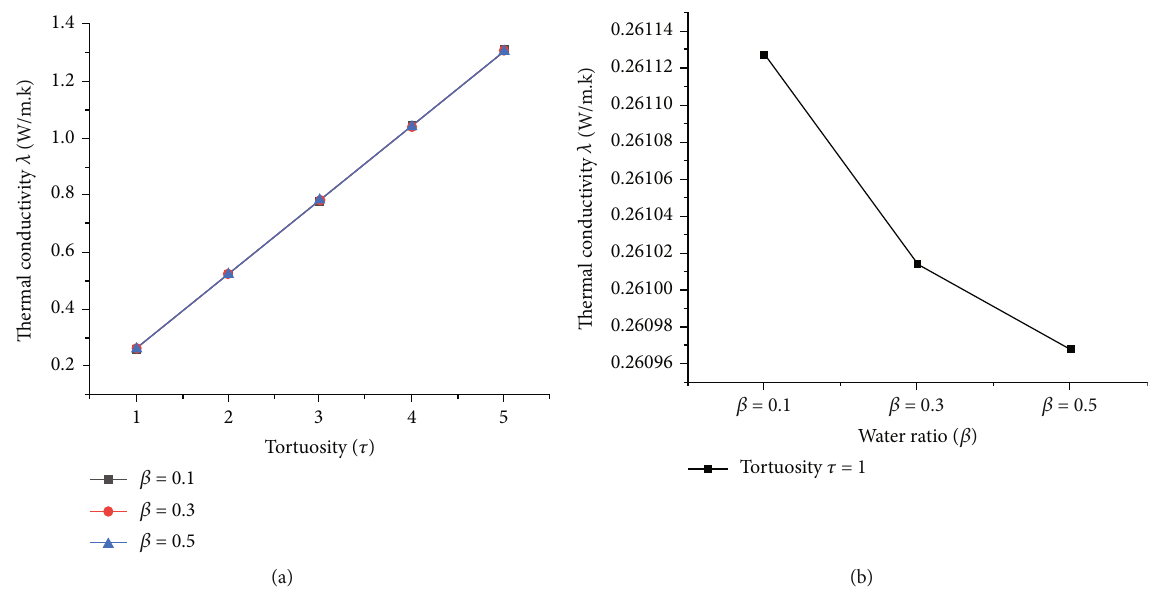
Figure 16: Relationship between thermal conductivity λ and tortuosity τ of the detailed volume-weighted average REV model with di ff erent water ratio β .